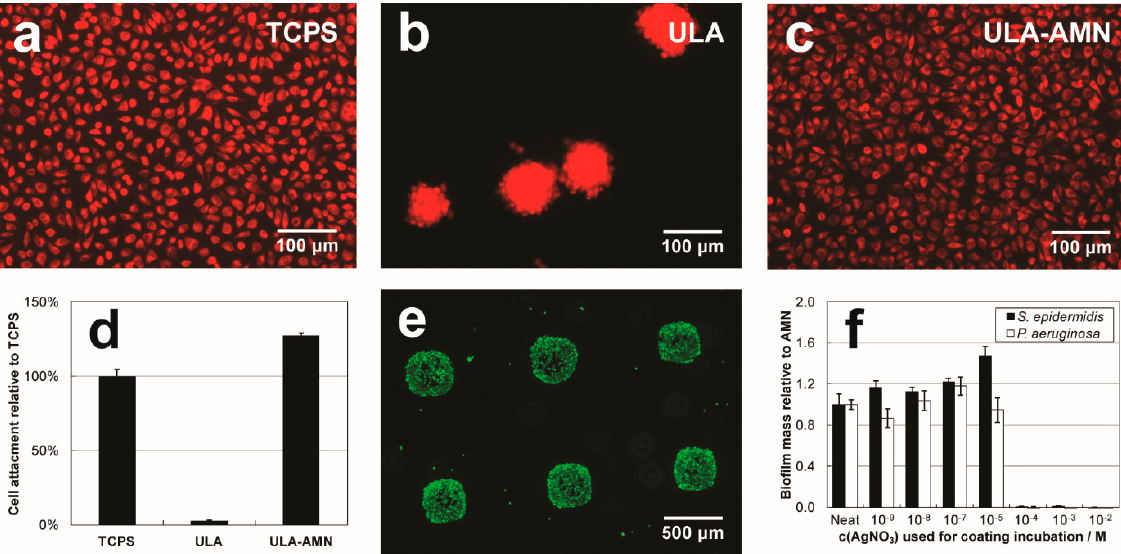
Figure 7. After 24 h cell culture, L929 mouse fibroblast cells show excellent attachment and spreading on tissue culture polystyrene (TCPS) control surfaces ( a ), while attachment is prevented on ultra-low attachment (ULA) control surfaces, leading to cell clumping ( b ). On AMN polymer coatings deposited on to ULA surfaces (ULA-AMN), cell attachment and spreading is equivalent to the TCPS surface, reversing the effect of the underlying ULA surface ( c ). The quantification of cell attachment via a cell proliferation assay assay supports these observations ( d ). Spatial control over L929 cell attachment was demonstrated on an ULA surface onto which an AMN solution was microarray contact printed ( e ). A 24 h crystal violet biofilm assay was used to demonstrate the effective antimicrobial activity of an AMN coatings that were incubated with different silver nitrate concentrations in contact with two representative bacterial strains, S. epidermidis and P. aeruginosa ( f ). Reproduced with permission from [11].